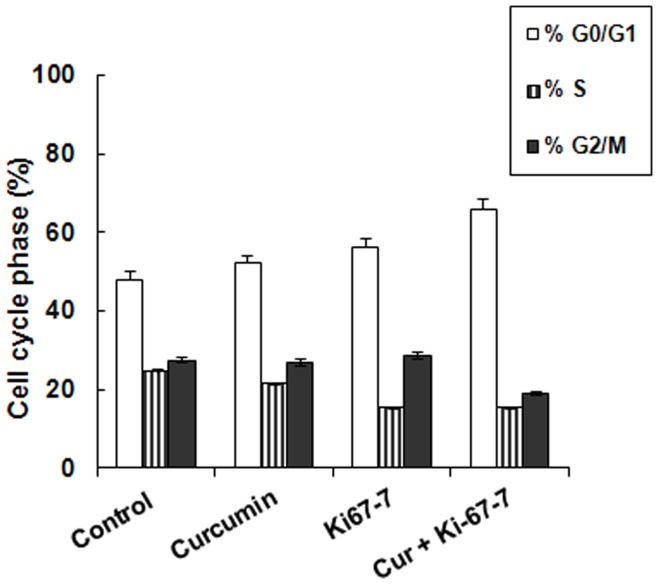
Effect of Ki-67-7 and curcumin on cell cycle phases.AY-27 cells were treated with Ki-67-7, curcumin or with both, as described earlier in legend to Figures 3A and 3B. At the end of the incubation period, the cells were treated with PI and the distribution of cells in various cell cycle phases were determined by flow cytometry as described in Methods. Cells were scored as percentage distribution of cells in each of the cell cycle phases (Go/G1, S and G2/M). Bars indicate values which are the means ± S.E of three determinations.